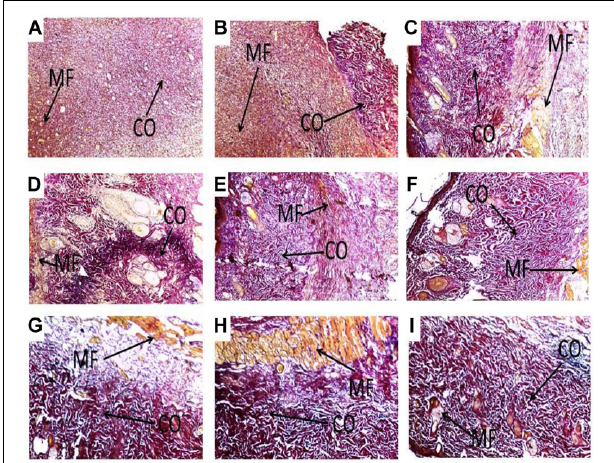
FIGURE 5 | Histological images showing influence of PLE and geraniin on collagen production in both PLE and geraniin-treated and untreated wound tissues. Full thickness wounds were created on the dorsal region and topically treated with PLE, geraniin, silver sulphadiazine, vehicle (cream only). Wound tissues were excised 13 days post wounding and sectioned. Serial sections were stained with Verhoeff–Van Gieson stain and evaluated microscopically for degree collagen deposition (Van Gieson stain × 400). Wound tissues were blindly examined by a pathologist. (A) Untreated wound tissues, (B) vehicle-treated (aqueous cream only) wound tissues, (C) 1% w/w silver sulphadiazine-treated wound tissues, (D) 0.25% w/w PLE-treated wound tissues, (E) 0.5% w/w PLE-treated wound tissues, (F) 1% w/w PLE-treated wound tissues, (G) 0.1% w/w geraniin-treated wound tissues, (H) 0.2% w/w geraniin-treated wound tissues, and (I) 0.4% w/w geraniin-treated wound tissues. CO, collagen fibers; MF, muscle